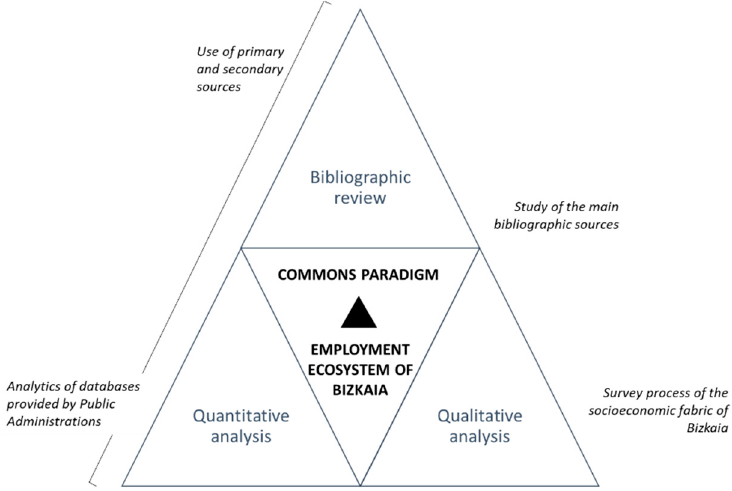
Figure 1. Representation of the Methodological Triangulation method.